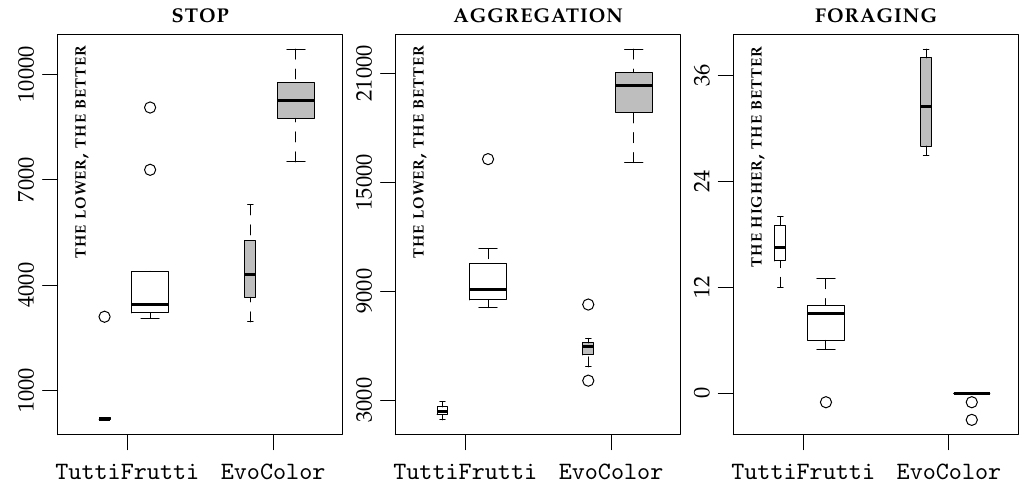
Figure 3. Performance obtained in the missions STOP (left), AGGREGATION (center), and FORAGING (right). The performance of TuttiFrutti is shown in white and the one of EvoColor in gray. Thin boxes represent results obtained in simulation and thick boxes the ones obtained with physical